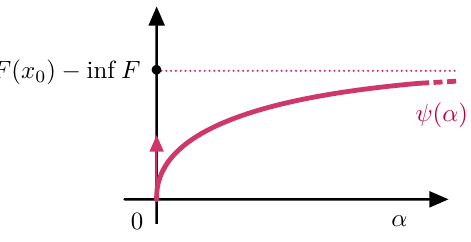
Figure 1 Shape of ψ defined in Eq. (3) in our situation of interest where D ( x k , x 0 ) explodes for any minimizing sequence ( x k ) k ∈ N (Proposition 1). When an optimization method satisfies Eq. (2) for some sequence ( α k ) k ∈ N then ψ ( α k ) bounds its convergence rate in objective